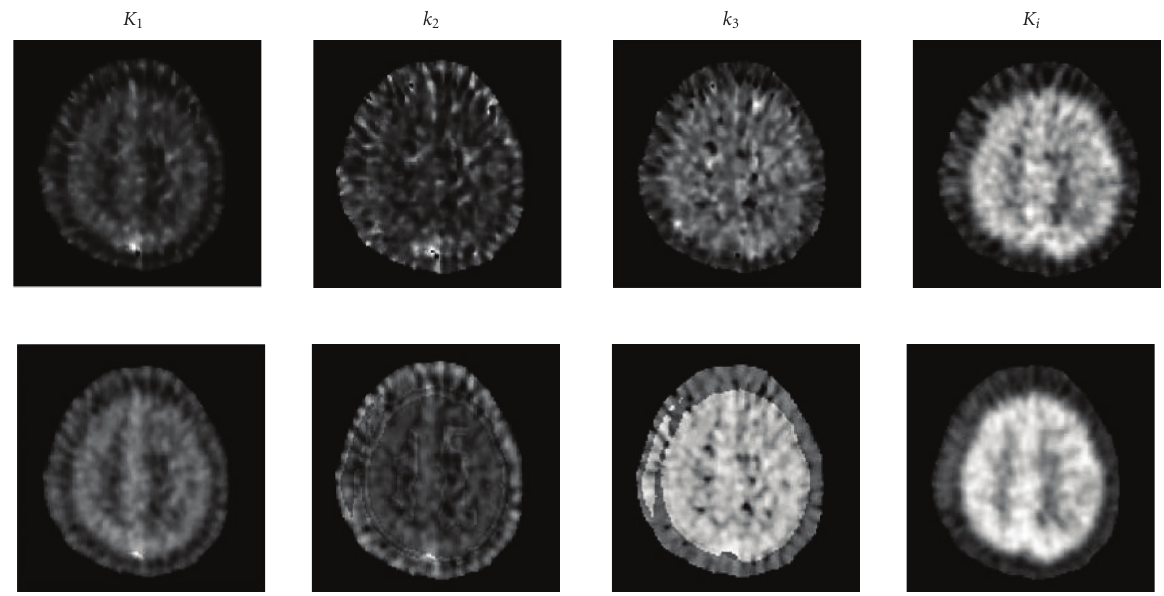
Figure 3: The parametric images of the 12th slice in clinical 3D FDG PET dynamic data, the first row is the images from LLS and the second row is the images from cLLS.